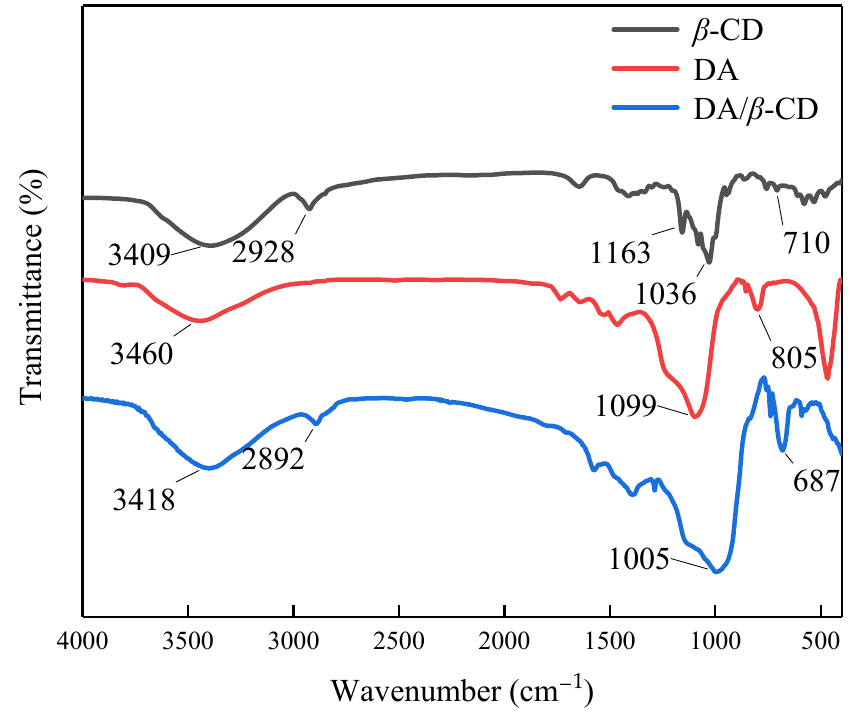
Figure 2. FT-IR spectra of DA, β -CD and DA/ β -CD composite. The surface morphology and microstructure of DA and DA/ β -CD were determined by scanning electron microscopy (SEM), and the corresponding images are shows in Figure